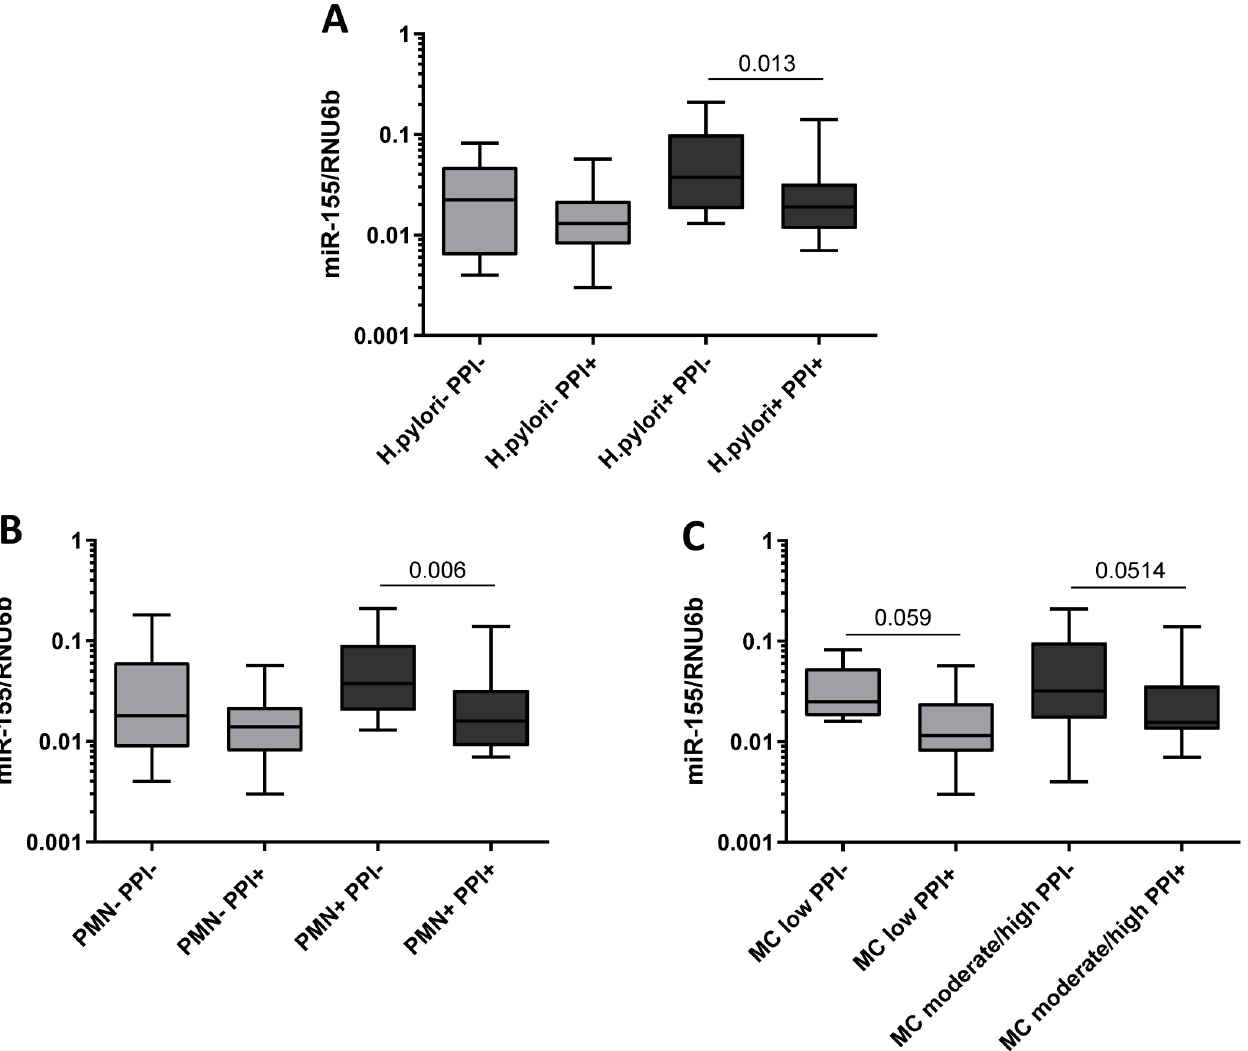
Fig 4. Subgroup analysis of miR-155 expression in regard of H . pylori infection, activity and chronicity of inflammation. (A) Comparison of miR-155 expression in gastric biopsies from antrum between patients with CNAG and with or without regular PPI-intake in relationship to (A) H . pylori -status ( H . pylori -/PPI-, n = 8; H . pylori -/PPI+, n = 11; H . pylori +/PPI-, n = 26; H . pylori +/PPI+, n = 17); ( B ) to the activity of Inflammation based on the updated Sydney score defined by the density of polymorphonuclear (PMN) infiltrate (PMN-/PPI-, n = 10; PMN-/PPI+, n = 11; PMN+/PPI-, n = 24; PMN+/PPI+, n = 17); and ( C ) to chronicity of inflammation based on the updated Sydney score defined by the density of mononuclear infiltrate (MC low PPI-, n = 7; MC low/PPI+, n = 12; MC moderate/high/PPI-, n = 27; MC moderate/high/PPI+, n = 16). PMN- = normal PMN infiltrate; PMN+ = mild-moderate PMN infiltrate; chronicity: MC low = normal/mild mononuclear infiltrate; MC moderate/high = moderate/marked mononuclear infiltrate. Values are reported as 2 Δ CT -values normalized to RNU6b.